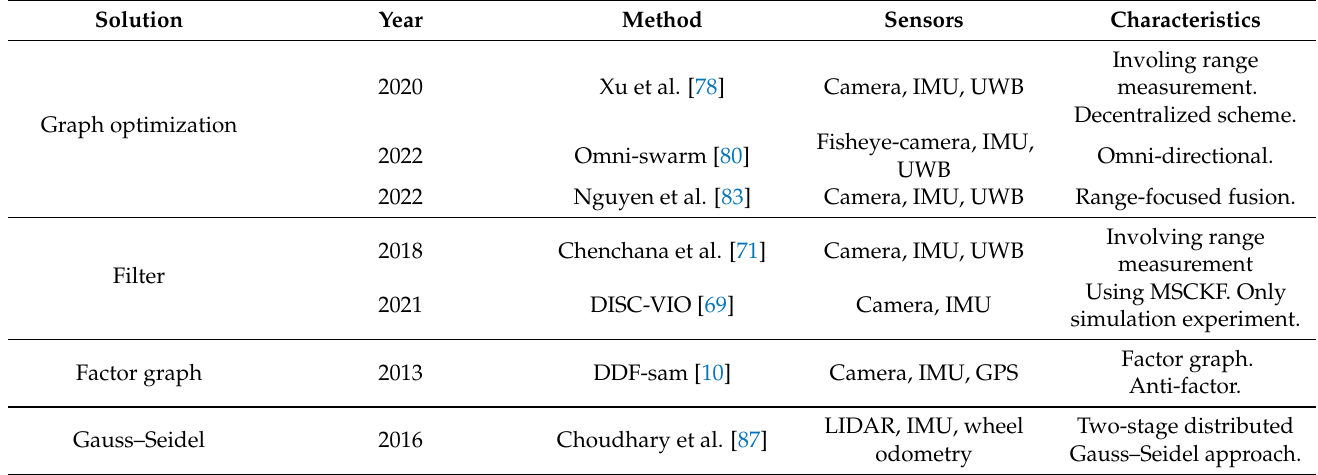
Table 3. Comparison of several multi-measurement fusion